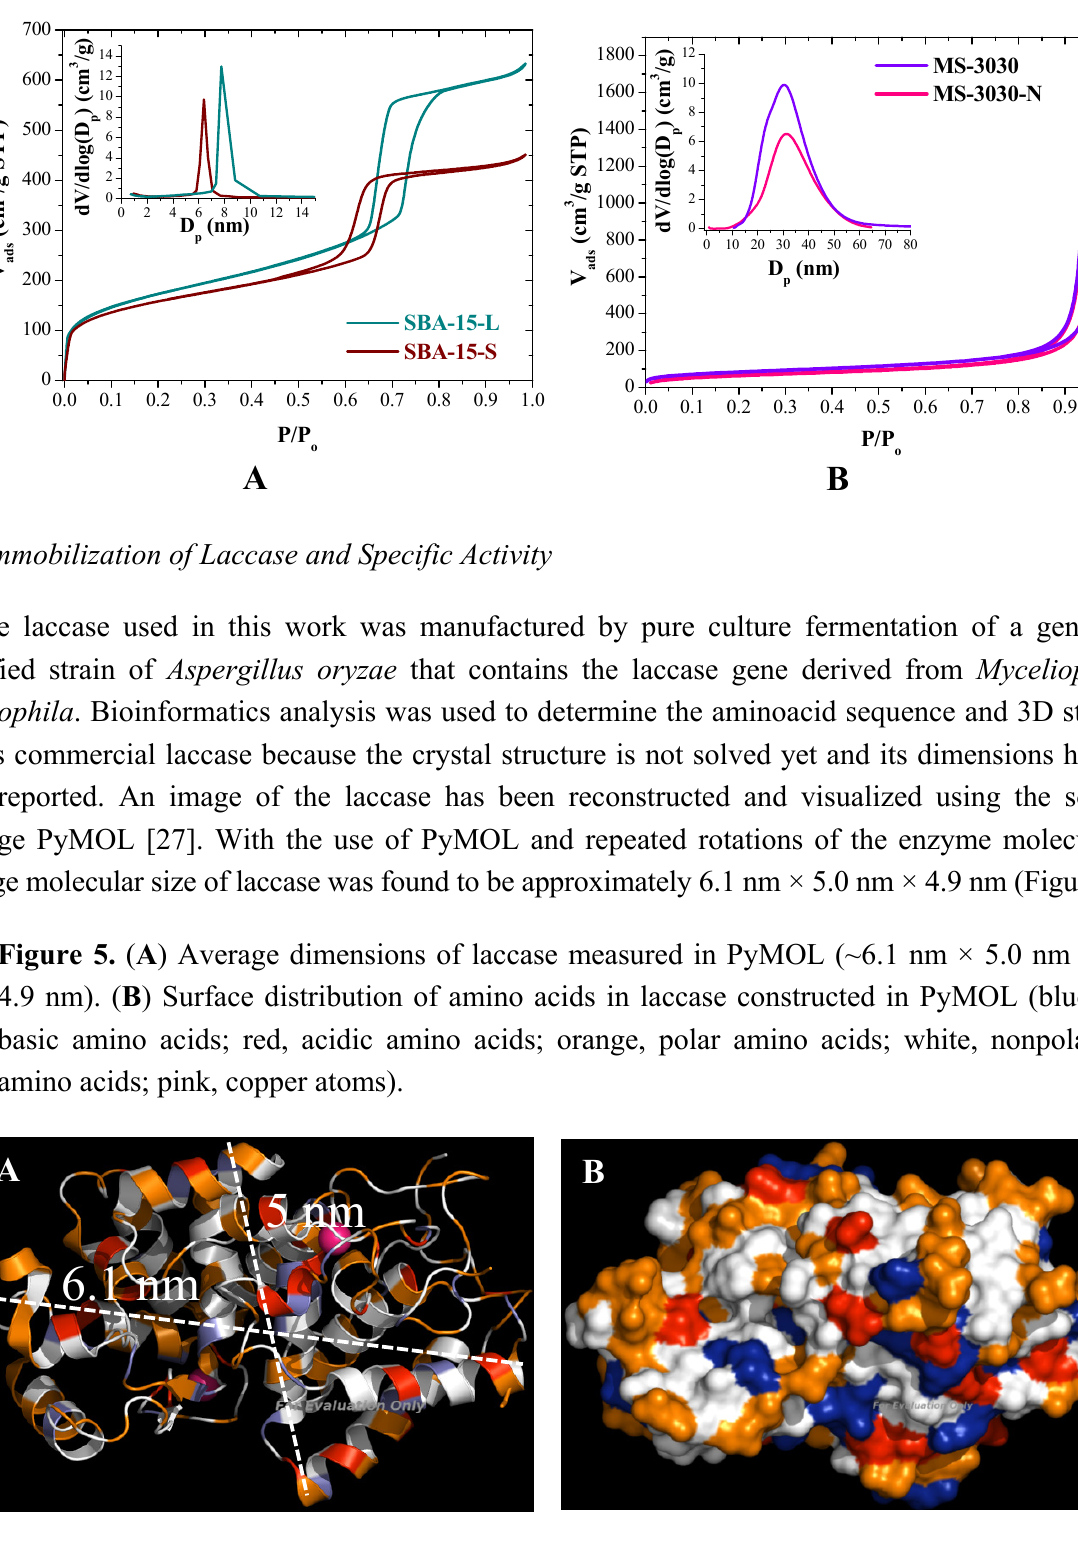
Figure 4. N adsorption-desorption isotherms and pore size distributions: ( A ) SBA-15-L 2 and SBA-15-S; ( B ) MS-3030 and MS-3030-N.